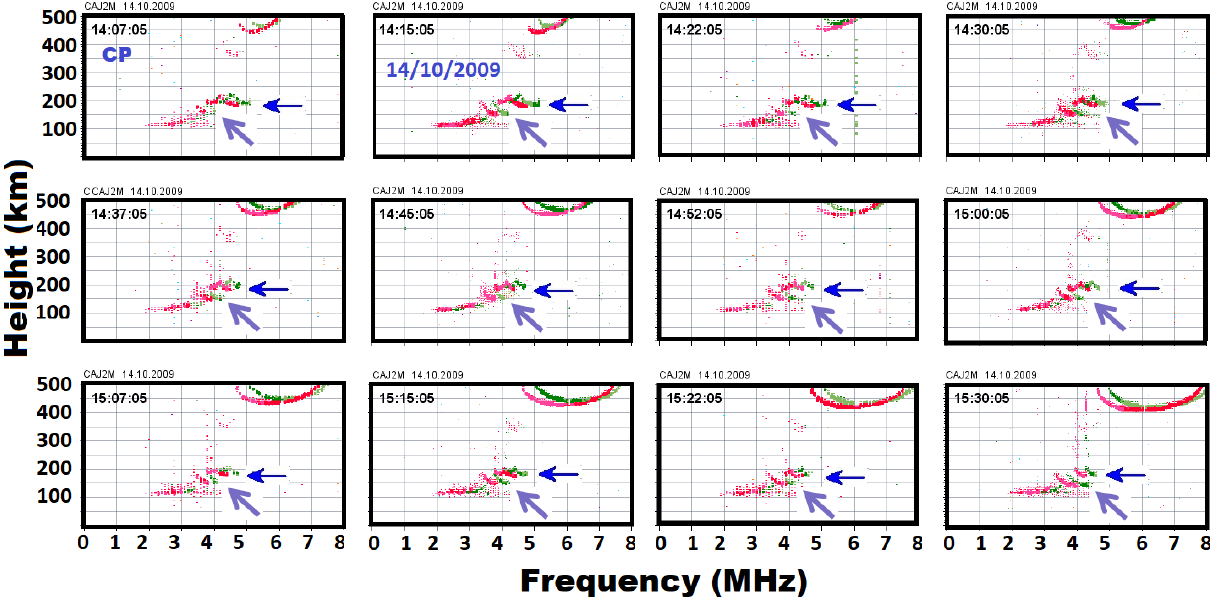
Figure 11. Sequence ionograms over CP showing the presence of simultaneous intermediate layer, one being initially detected in 180km height and the other in 150km.